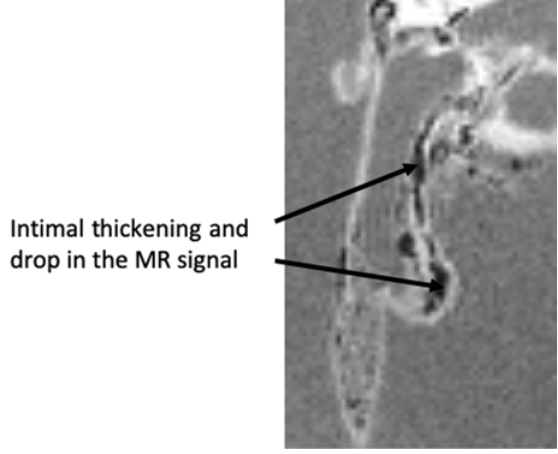
Figure 5. MRI magnitude image of the agarose-embedded aorta after isolation from one Apoe − / − mouse following in vivo injection of NE-P3 (#5) in the tail vein. Black arrows highlight the decrease in the MR signal.